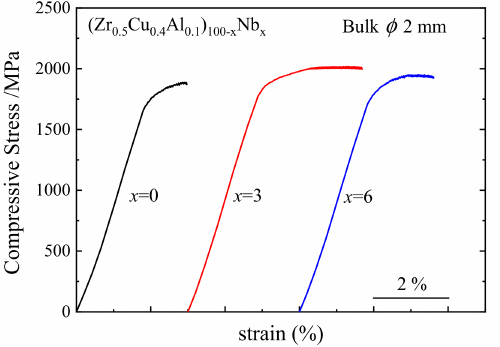
Figure 2. Quasi-static compressive stress-strain curves of 2 mm diameter (Zr 0.5 Cu 0.4 Al 0.1 ) 100-x Nb x (x = 0, 3, 6 at.%) BMG